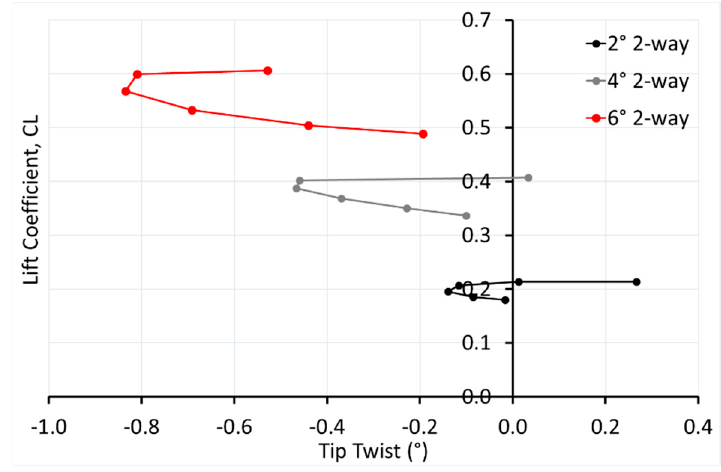
Figure 12. Lift coefficient vs. tip twist.